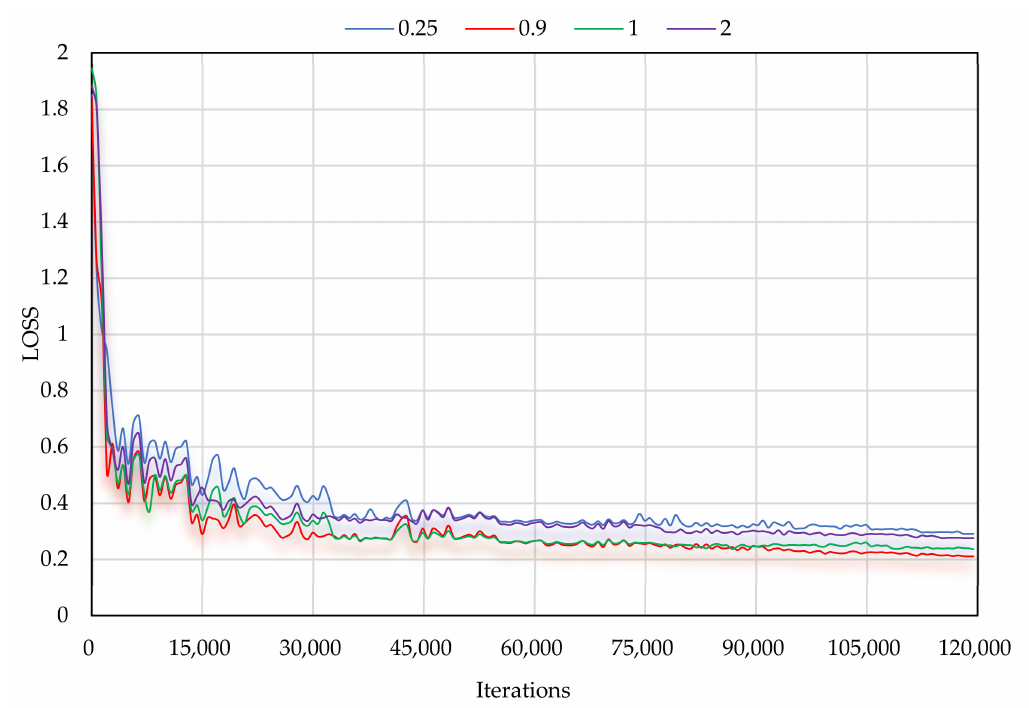
Figure 7. Evaluation of Loss curve with the Y t